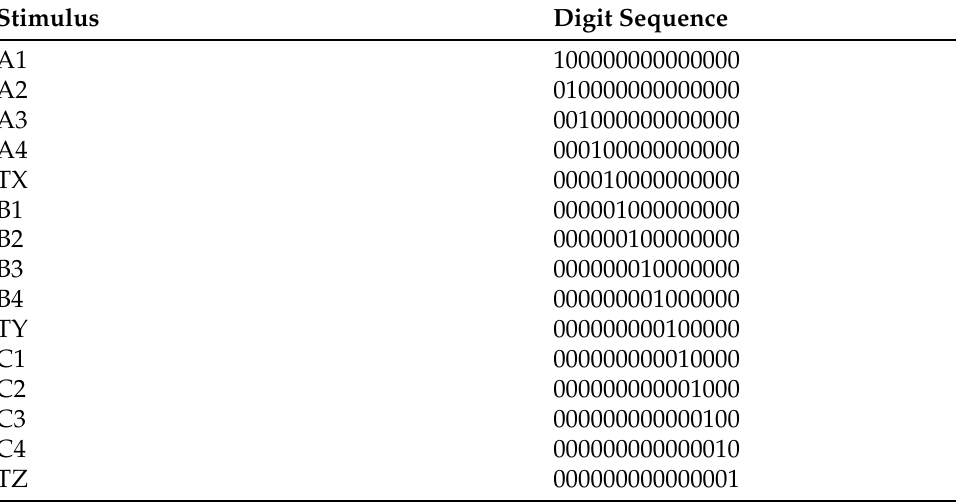
Table 1. Encoding of the stimulus for input